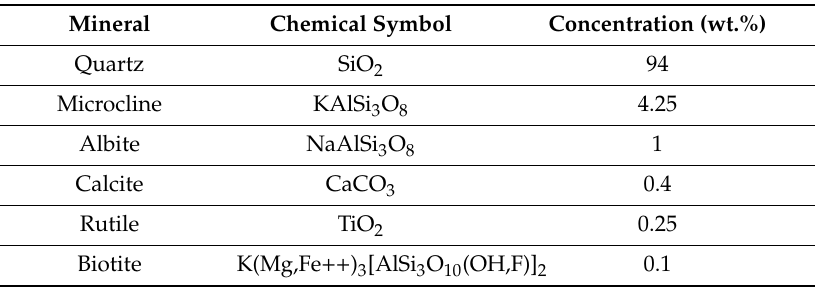
Table 1. X-ray di ff raction (XRD) of Bu ff Berea sandstone rock sample.